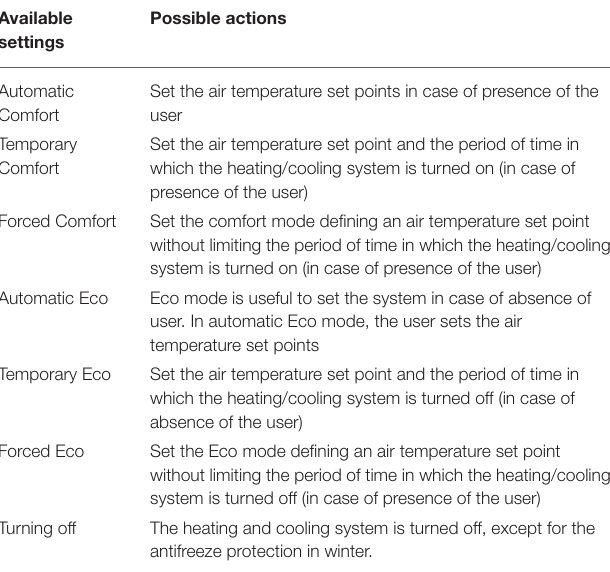
TABLE 2 | Settings mode available for users. Available settings